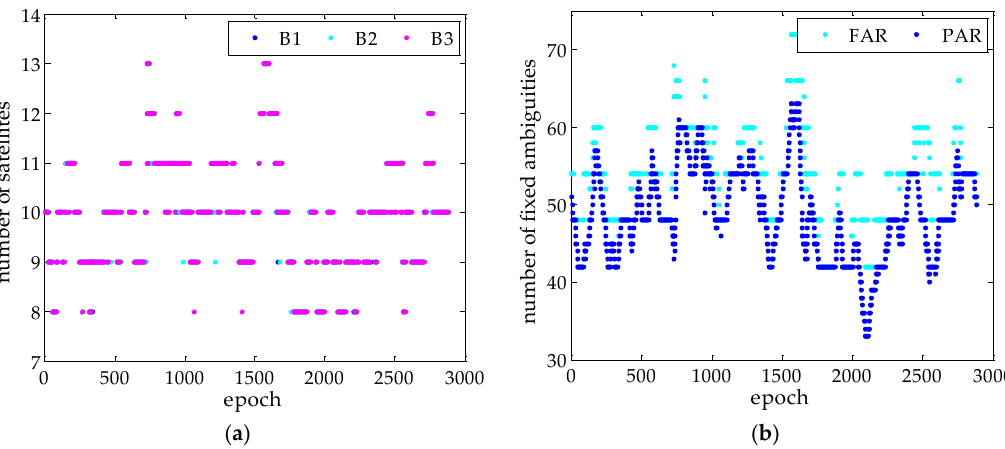
Figure 3. Visible satellite number for each baseline and fixed ambiguity number for FAR and PAR: ( a ) is the visible satellite number; and ( b ) is the fixed ambiguity number.